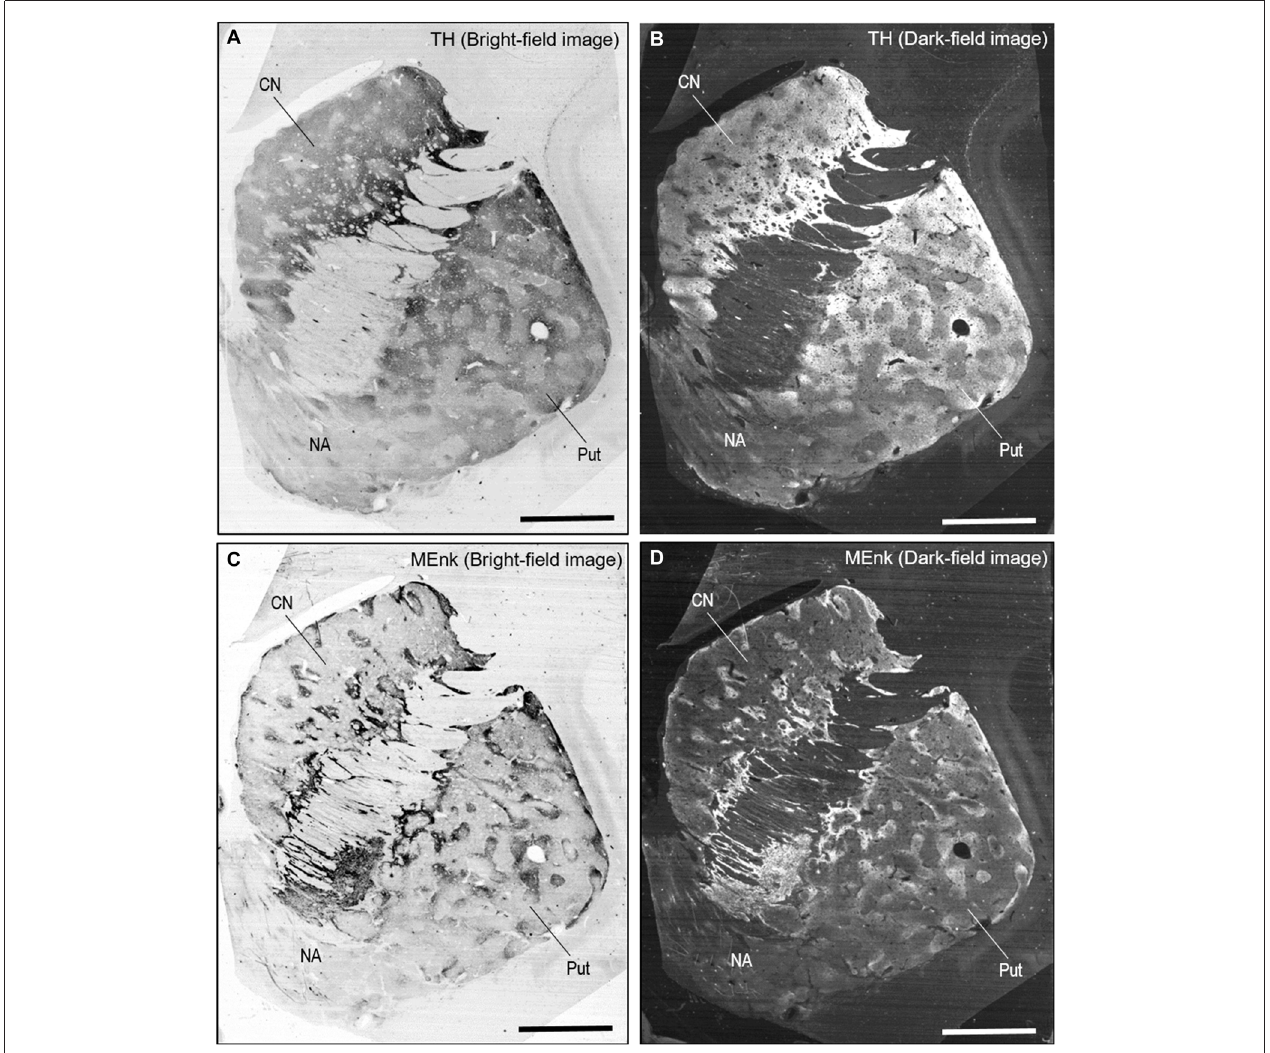
FIGURE 2 | Non-homogeneous distribution of TH in the human neostriatum. (A,B) Bright-field (A) and dark-field (B) images taken from a frontal section of the striatum stained with diaminobenzidine (DAB) for TH. (C,D) Bright-field (C) and dark-field (D) images taken from a frontal section of the striatum stained with DAB for [Met]-enkephalin (MEnk), a marker for striosomes (patches). Note that they are contiguous to those shown in (A,B) . Abbreviations: CN, caudate nucleus; Put, putamen; NA, nucleus accumbens. Scale bars: 5 mm.